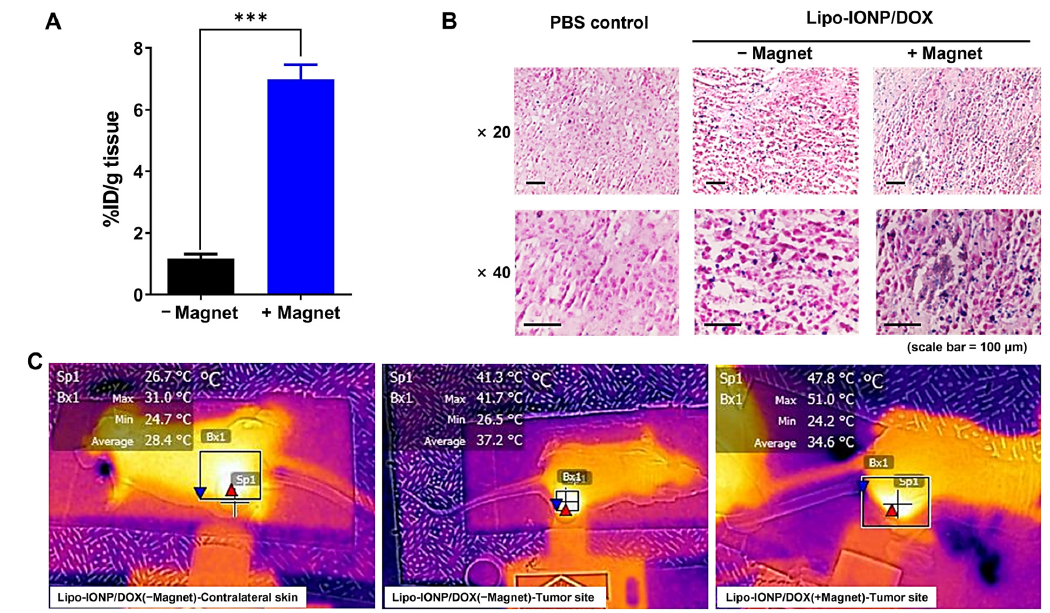
Figure 8. Magnetic tumor targeting of Lipo-IONP/DOX and its photothermal effects in B16F10 s.c. allograft tumor mouse model. ( A ) Tumor accumulation profiles of Lipo-IONP/DOX. ( B ) Histological analysis of the tumor distribution of Lipo-IONP/DOX. IONP were stained blue and cells pink by the Prussian blue staining. ( C ) Representative infrared/brightfield overlapped images of Lipo-IONP/DOX administered mice during laser irradiation. When the average tumor size reached 300 mm 3 , the mice were divided into 3 groups (N = 5): (1) PBS, (2) Lipo-IONP/DOX( − Magnet), and (3) Lipo-IONP/DOX(+Magnet). The mice were administered with either PBS or Lipo-IONP/DOX (24 mgFe/kg as Lipo-IONP; 4 mg/kg as DOX) via tail vein injection after anesthetization. For the Lipo-IONP/DOX(+Magnet) group, an external magnetic field was locally applied for 30 min to the tumor region after injection of the Lipo-IONP/DOX. At 2 h post-administration, the tumors were harvested to quantify the Lipo-IONP/DOX contents or histological analysis. To evaluate the in vivo photothermal effects, using the identical animal model, for 2 groups (N = 5): Lipo-IONP/DOX( − Magnet) and (3) Lipo-IONP/DOX(+Magnet), the tumor regions were irradiated with a diode laser ( λ = 885 nm) with varying laser powers (0.5–0.95 W) at 2 h post-administration. The highest temperature of the tumor surface (or the contralateral region) was monitored using an IR camera (E5, FLIR Systems). The statistically significant difference in the tumor accumulation amounts between the two groups was compared by Student’s t-test. (GraphPad). *** p < 0.001 (Lipo-IONP/DOX: doxorubicin-loaded liposomal iron oxide nanoparticle). Table 2. Maximum tumor temperature profiles of Lipo-IONP/DOX-treated mice with photothermal treatment.